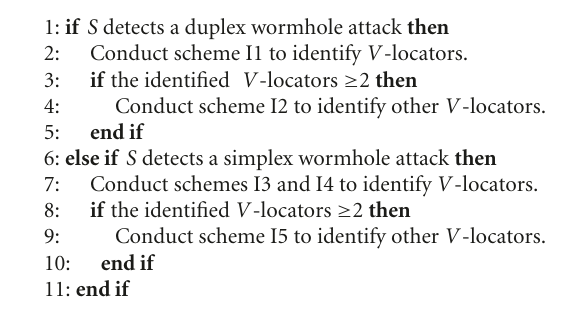
Algorithm 2: Basic Valid Locators Identification Approach.